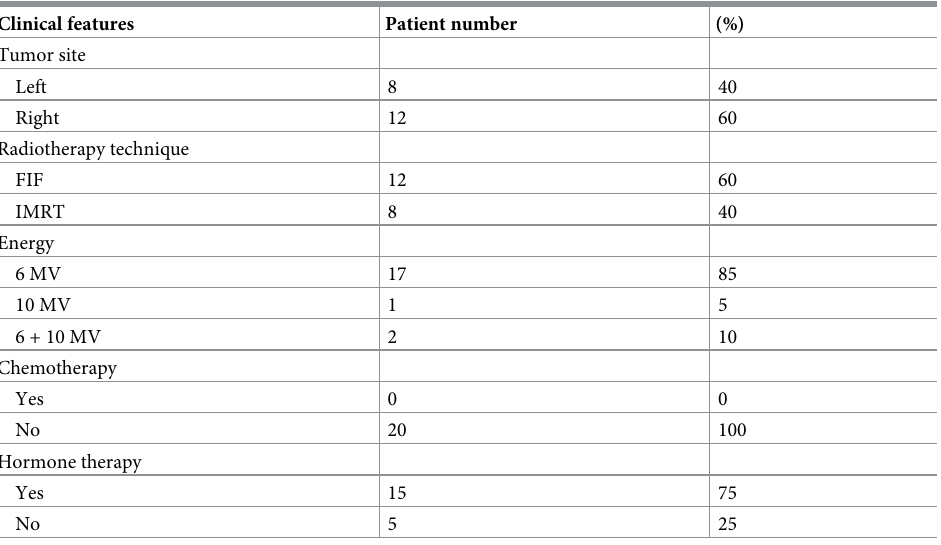
Table 1. Characteristics and treatment factors of patients (n = 20). Clinical